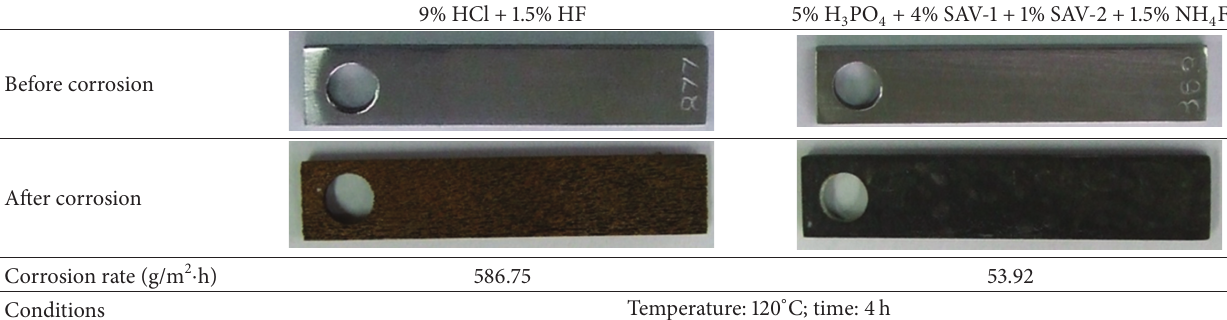
Table 1: Comparison of corrosion rate of multichelating acid and conventional mud